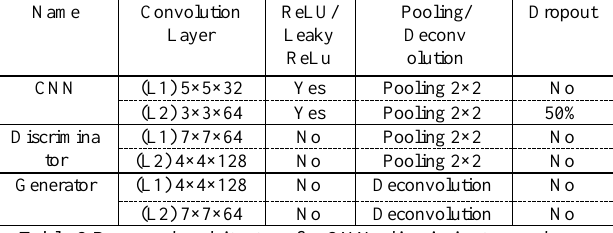
Table 2.Proposed architecture for CNN, discriminator, and